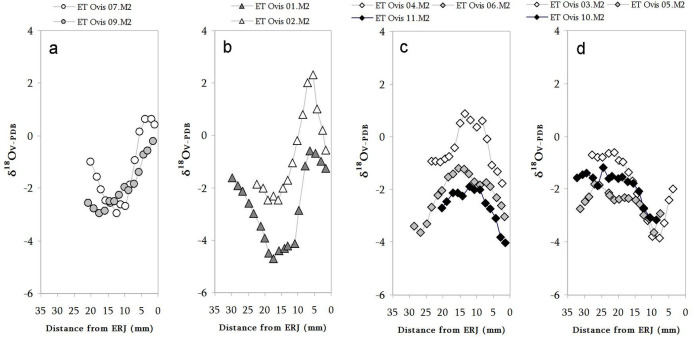
Sequential δ18OV-PDB values in all second molars, classified according to the position in tooth crown of the maximum oxygen event in the tooth crown.Type a: max. δ18OV-PDB values between 0 to 5mm; Type b: max. δ18OV-PDB values between >5 to 10 mm; Type c: max. δ18OV-PDB values between 10 to 15mm; and Type d: max. δ18OV-PDB values between 20 to 30mm.